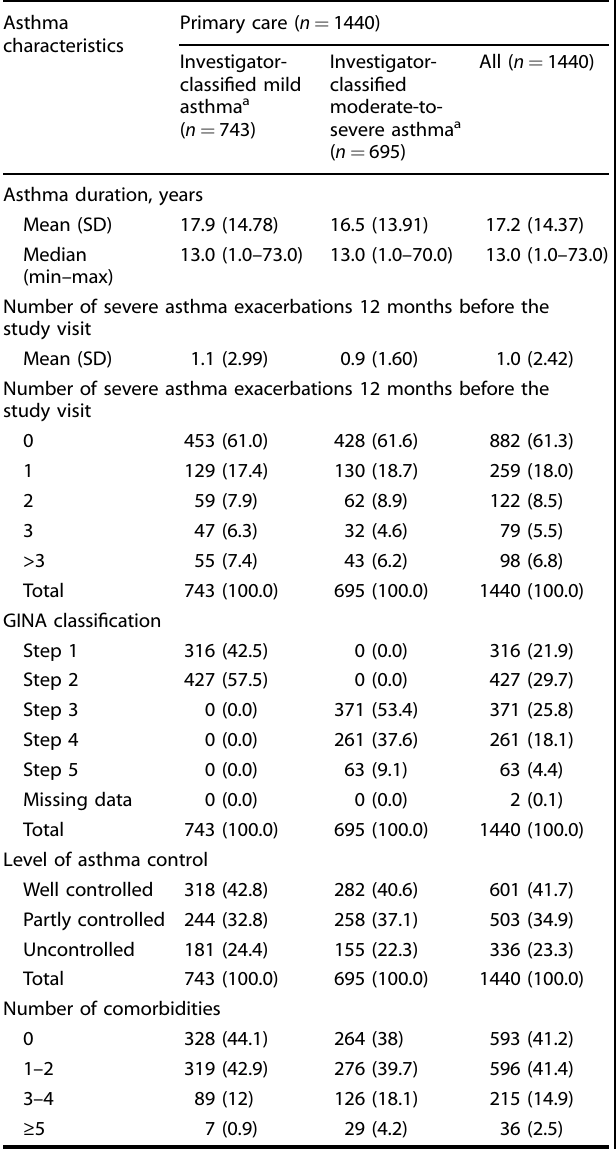
Table 2. Asthma characteristics of the SABINA III PCP cohort according to investigator-classi fi ed asthma